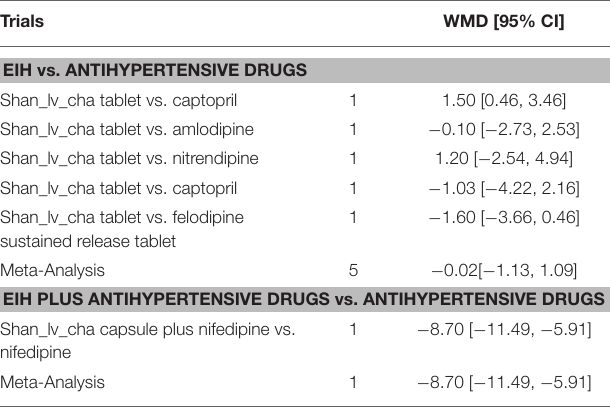
TABLE 6 | Analyses of diastolic blood